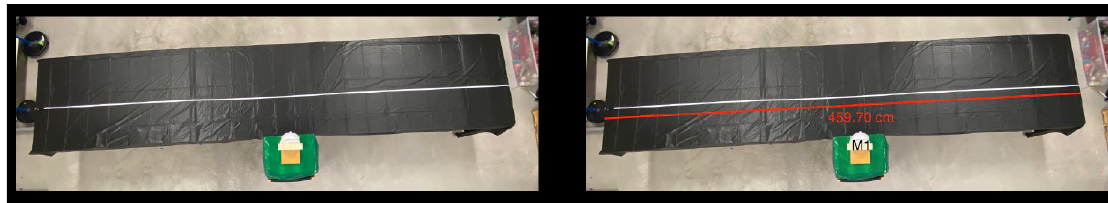
Fig 4. Lateral droplet spread when sitting. A white metric measuring tape with centimeter and millimeter markings is shown in each figure. (A) A bird’s eye view photo of the mannequin simulating the cough, placed in the middle of a long table, is displayed. (B) The measurement of the length of the table is shown and the mannequin at the center is labeled M1.